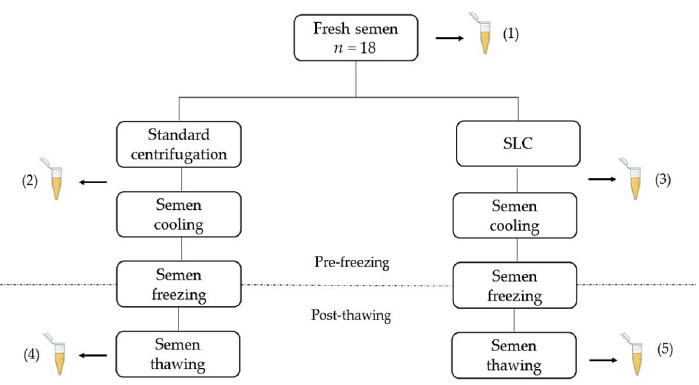
Figure 1. Flow chart describing the experimental design. Treatment groups: (1) = fresh semen; (2) = standard centrifuged semen; (3) = single layer centrifugates (SLC)-selected semen; (4) = standard centrifuged semen post-thawing; (5) = SLC-selected semen post-thawing. n = 18 semen samples (9 of optimal (normal morphology ≥ 80%) and 9 of suboptimal (normal morphology between 60 and 79%) semen quality).